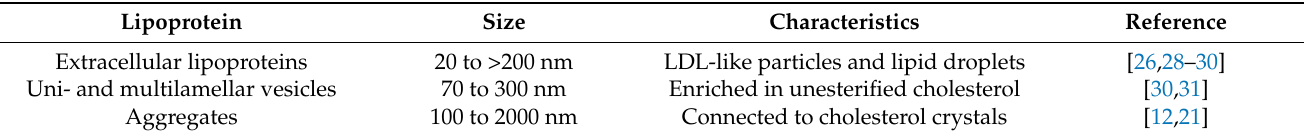
Table 1. Sizes of lipoproteins and lipid particles isolated from human atherosclerotic